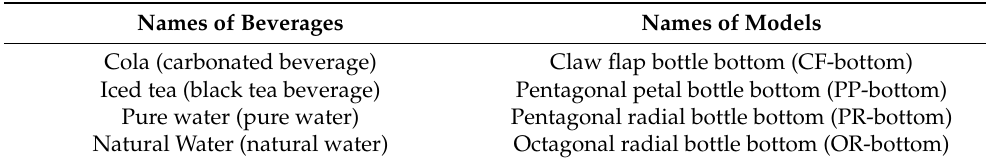
Table 1. Names of beverages and corresponding shape